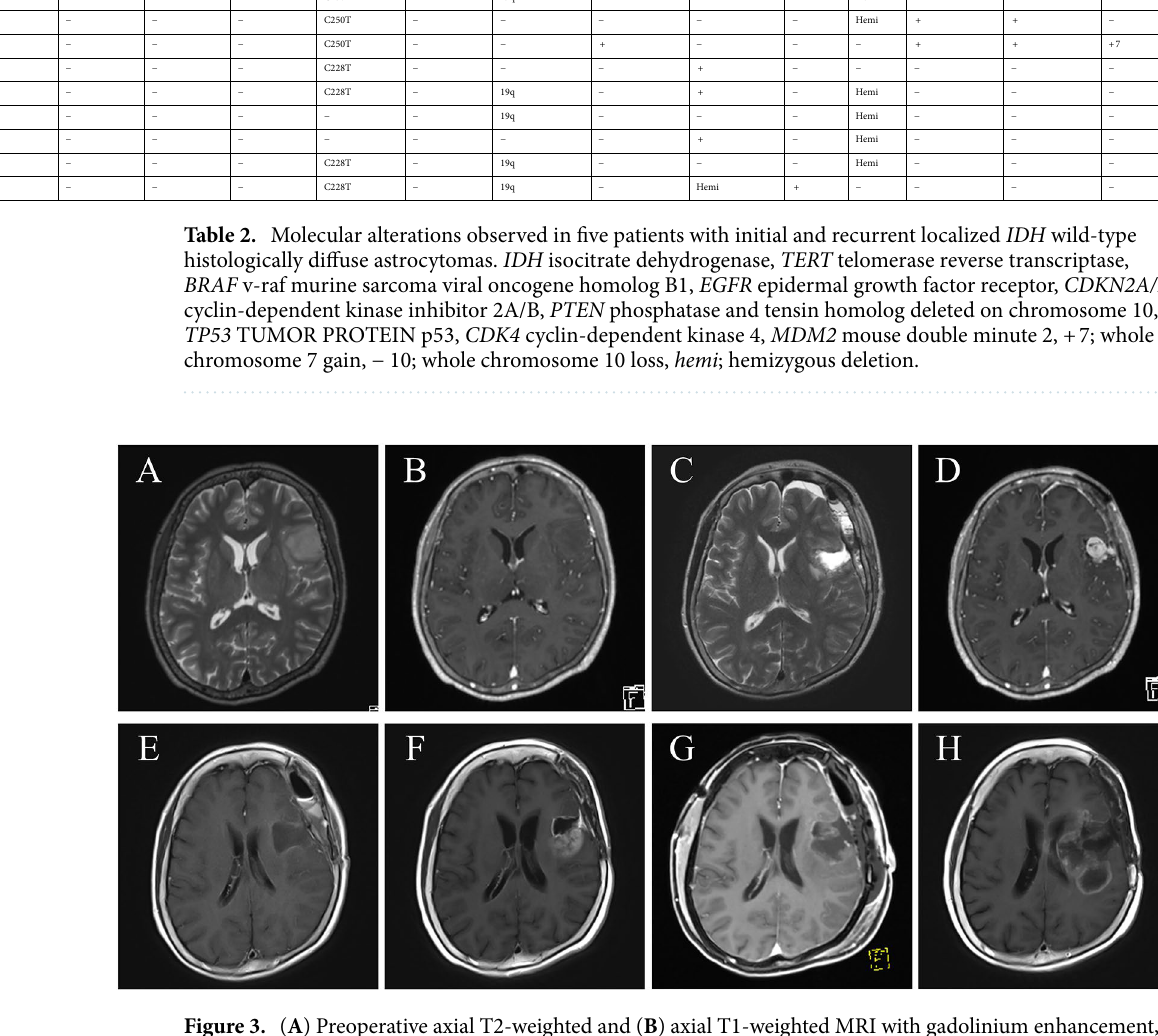
Figure 3. ( A ) Preoperative axial T2-weighted and ( B ) axial T1-weighted MRI with gadolinium enhancement, showing a high-intensity area with no enhancement in the left inferior frontal gyrus forming a localized tumor mass. ( C ) Postoperative axial T2-weighted MRI showing no tumors due to gross-total resection (first surgery). ( D ) Axial T1-weighted MRI with gadolinium enhancement performed about 6 months after the first surgery, showing nodular enhancement in the left frontal surgical cavity. ( E ) Postoperative axial T1-weighted MRI with gadolinium enhancement, showing no tumors due to gross-total resection (second surgery). ( F ) Axial T1-weighted MRI with gadolinium enhancement performed about 4 months after the second surgery, showing enhancing mass lesion in the surgical cavity again. ( G ) Postoperative axial T1-weighted MRI with gadolinium enhancement, showing no tumors owing to gross-total resection (third surgery). ( H ) Axial T1-weighted MRI with gadolinium enhancement at last follow-up, showing recurrent tumor. Tumor progression could not be